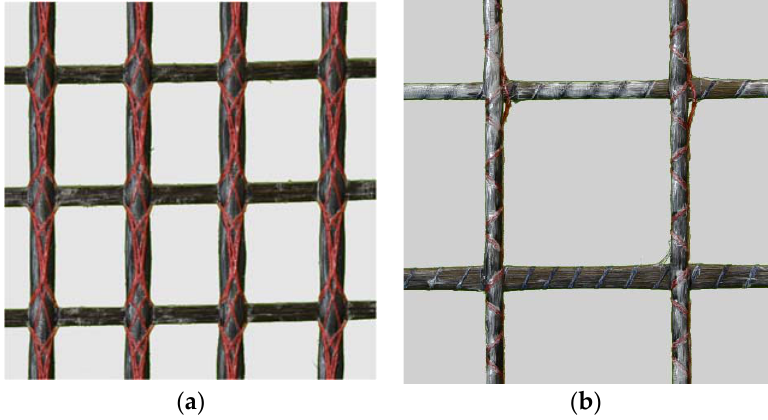
Figure 5. Geometries of the used textiles ( a ) geometry 1 (T1); ( b ) geometry 2 (T2).